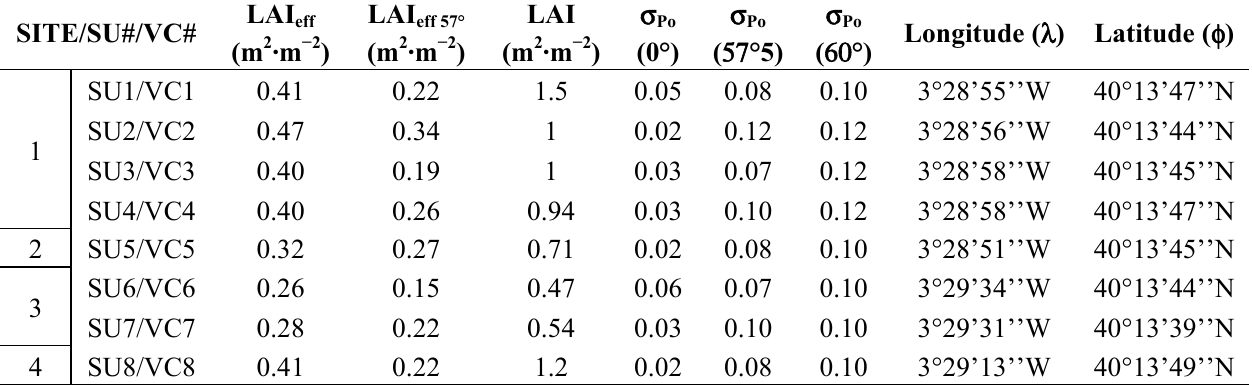
Table 1. Summary of Gap Fraction and LAI values for the Sampling Units